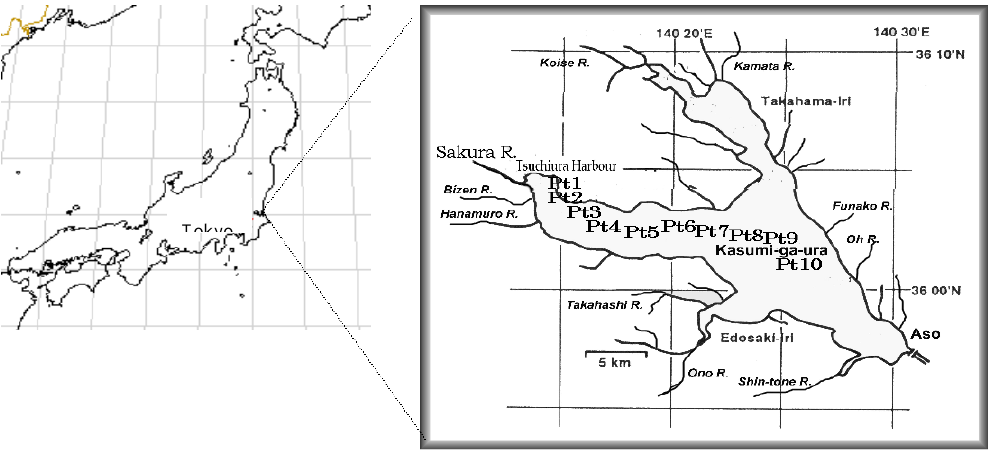
Figure 2 . Locations of Pt1 to Pt10 at Lake